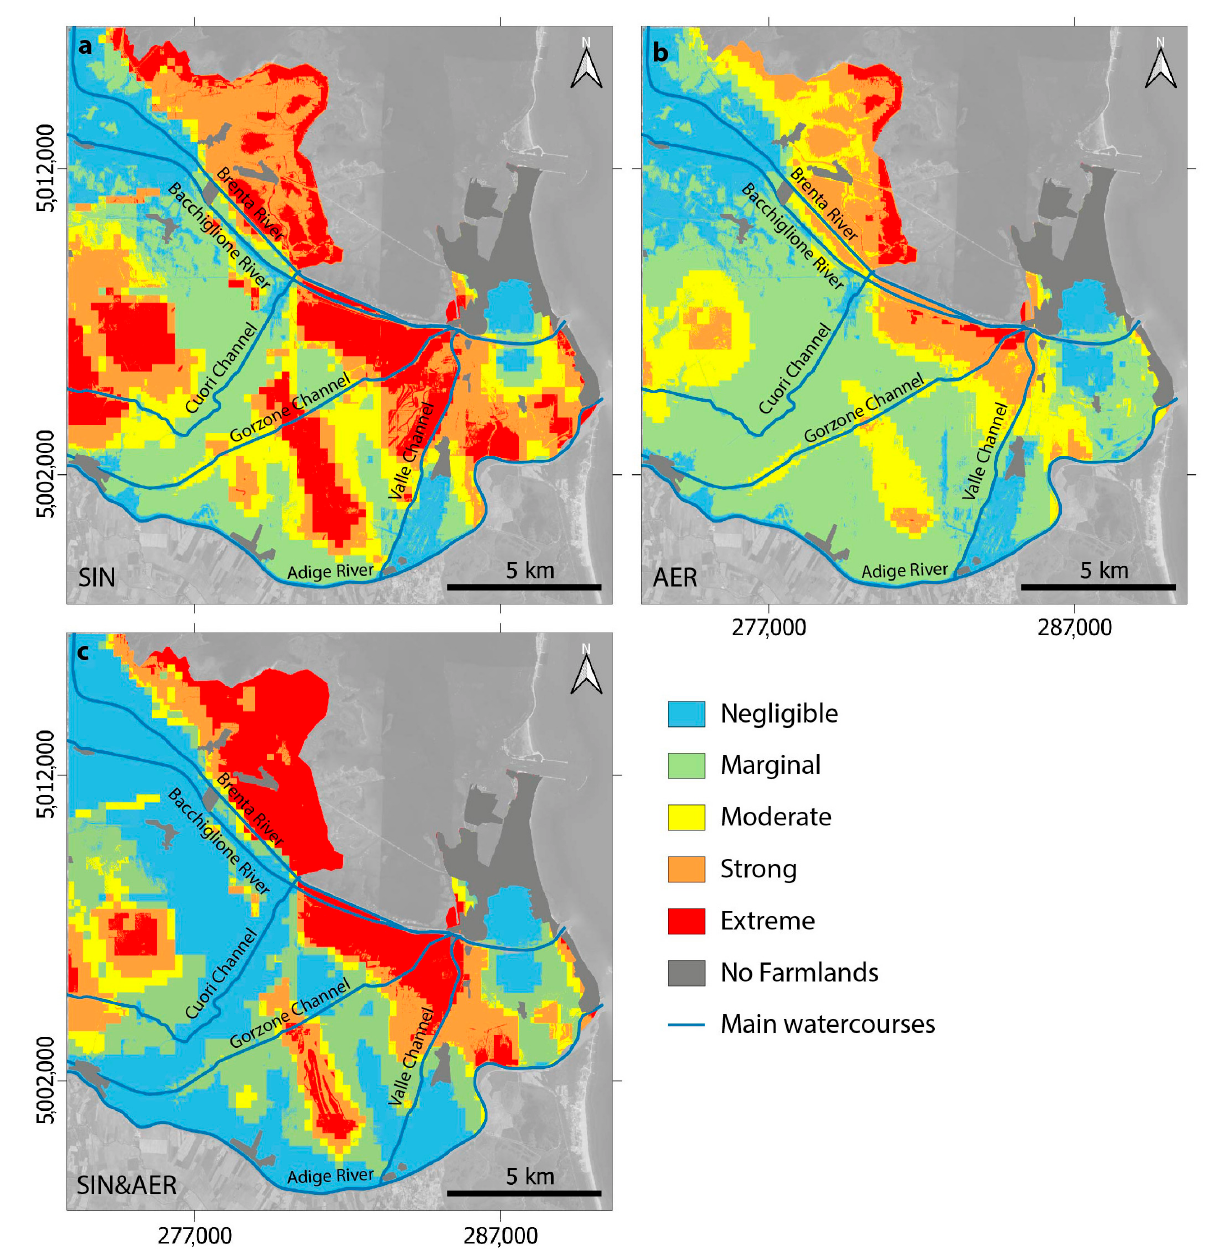
Figure 10. Maps of the vulnerability of farmlands to saltwater intrusion. The maps were computed while accounting for the sensitivity of the farmlands and the three hazard statuses: ( a ) SIN hazard, ( b ) AER hazard, and ( c ) SIN&AER hazard. Coordinate system: UTM33, WGS84. The vulnerability map, computed by considering the SIN-hazard status, results in rather equally spatially distributed classes, covering 15% to 25% of the area (Figure 10).